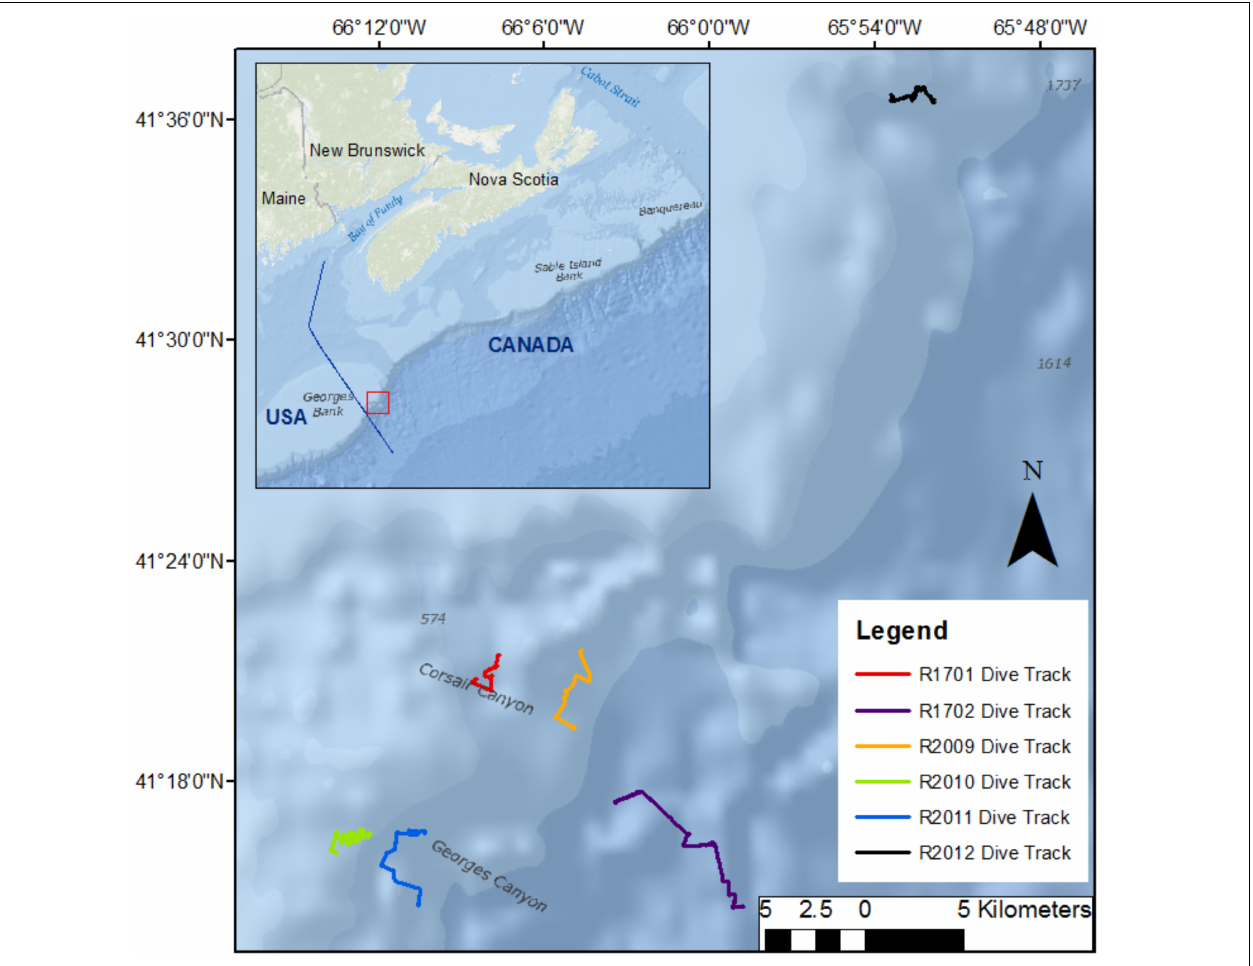
FIGURE 2 | Location of dive tracks followed by the remotely operated vehicle ROPOS in Georges Canyon in 2017 (R2010, R2011), Corsair Canyon in 2014 (R1701 and R1702) and in 2017 (R2009) and Fiddlers Cove in 2017 (R2012) on the Canadian continental shelf break and slope. Bathymetry data from: World Ocean Base (Esri, DeLorme, GEBCO, NOAA NGDC, and other contributors; World Ocean Reference (Esri, GEBCO, NOAA, National Geographic, DeLorme, HERE, Geonames.org, and other contributors).